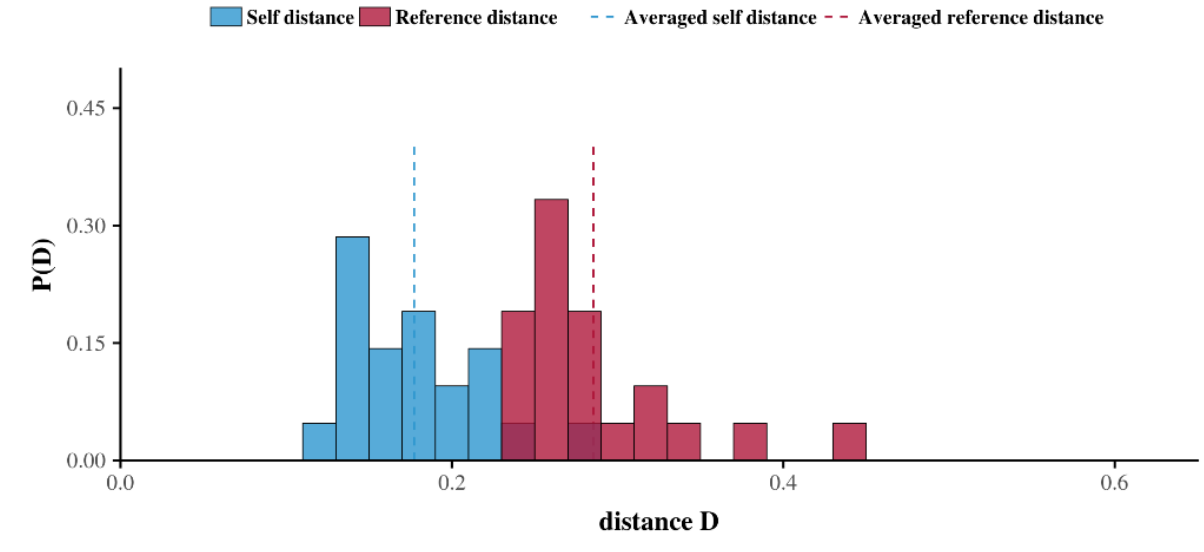
Figure 6. Histogram showing the average persistence for mixed outgoing-incoming telephone calls. Red bars represent the averaged reference distances, whereas blue bars represent the averaged self-distances for all the egos in the study. Blue and red dashed lines represent the averaged self-distance and the averaged reference distance of the overall population in the study, respectively. The results suggest that, on average, individuals have a self-distance that is less than their reference distance, which implies that, when mixing outgoing and incoming telephone calls without distinction, the daily rhythms of older adults persist over